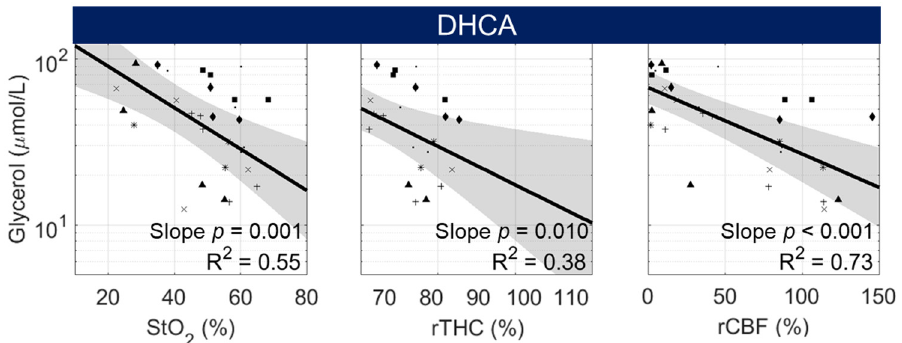
Figure 5. Correlation between Cerebral Glycerol and Cerebral Hemodynamics in DHCA Animals with a 60 min Delay between Sampling Methods. Correlation data from individual animals are designated by a unique symbol within DHCA animals (i.e., animals randomized to DHCPB and SACP groups). When accounting for a 60 min delay between cerebral hemodynamics and microdialysis sample collection from which glycerol concentrations were analyzed, in DHCA animals, a significant negative slope effect was detected in the linear mixed-effects model examining the relationship between log-normalized glycerol concentration and StO 2 , rTHC, and rCBF. No significant correlations were observed at this delay time in the “No DHCA” animals.